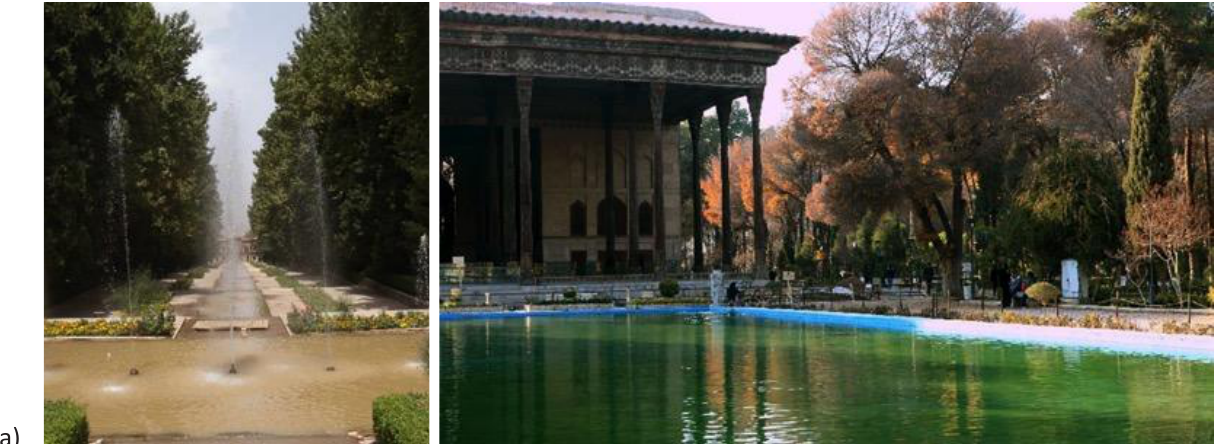
Figure 5. The system of Irrigation and water circulation in Persian gardens. (a) the view of terraced pools and streams of Shahzadeh-Mahan Garden. Photo by: Maite Elorza from Flickr; (b) The view of Central main pool of Chehel- sotun garden. Photo by: Ni n ara